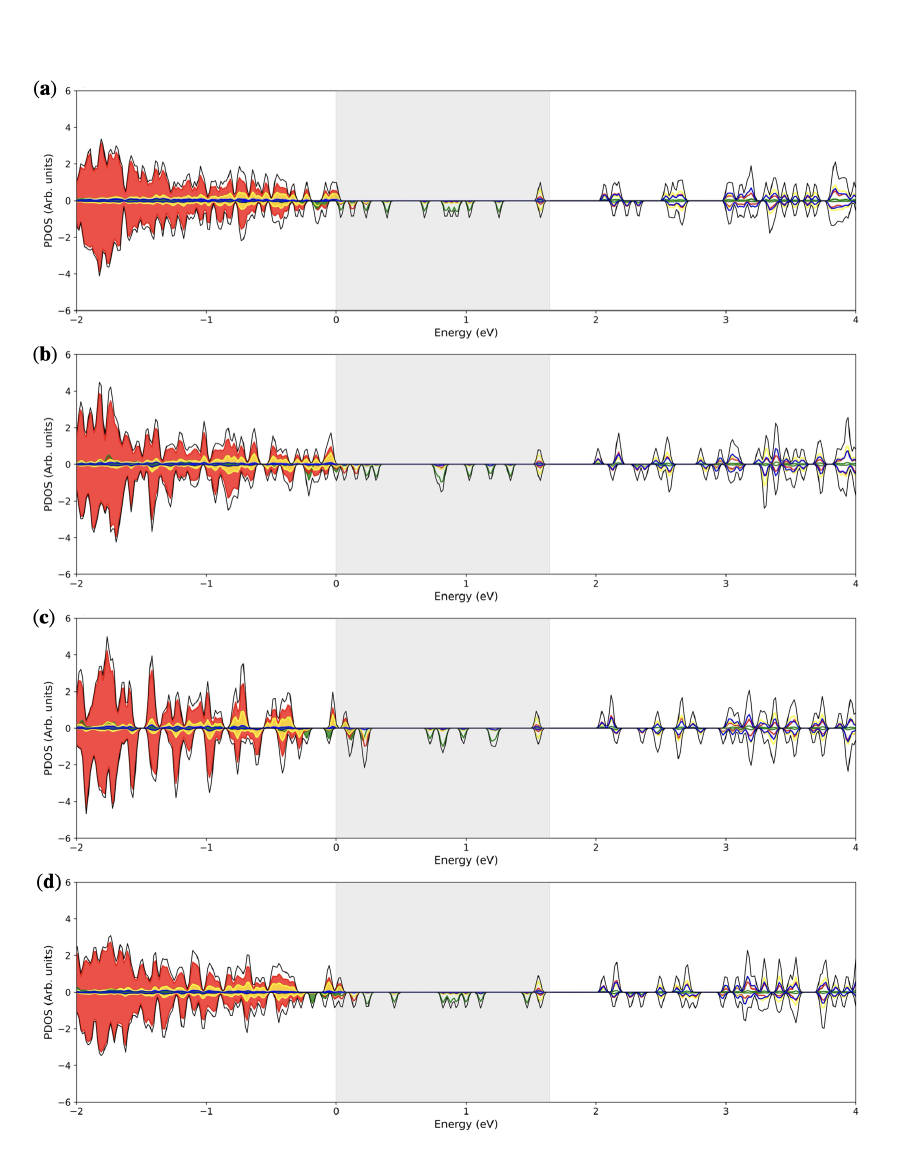
Figure 5. PDOS for configurations ( a ) β 2.1 , ( b ) β 2.2 , ( c ) β 2.3 and ( d ) β 2.4 (copper = red, sulfur = yellow, aluminium = blue and iron =